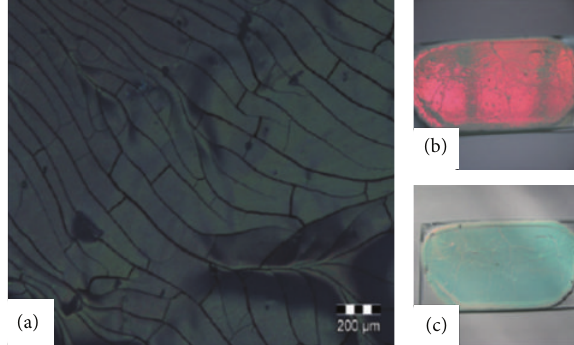
Figure4:Lightdiffraction:iridescenceofpolymercolloidalspheres: (a) optical microscopy; (b) photo recorded at an angle of 45 ∘ following thermal treatment; (c) photo recorded at an angle of 90 ∘ following thermal treatment [31].